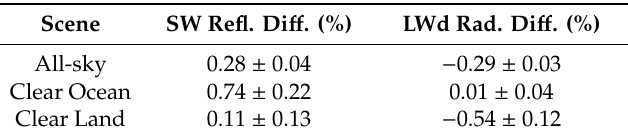
Table 2. Di ff erences in the global average SW reflectance and daytime LW (LWd) radiance